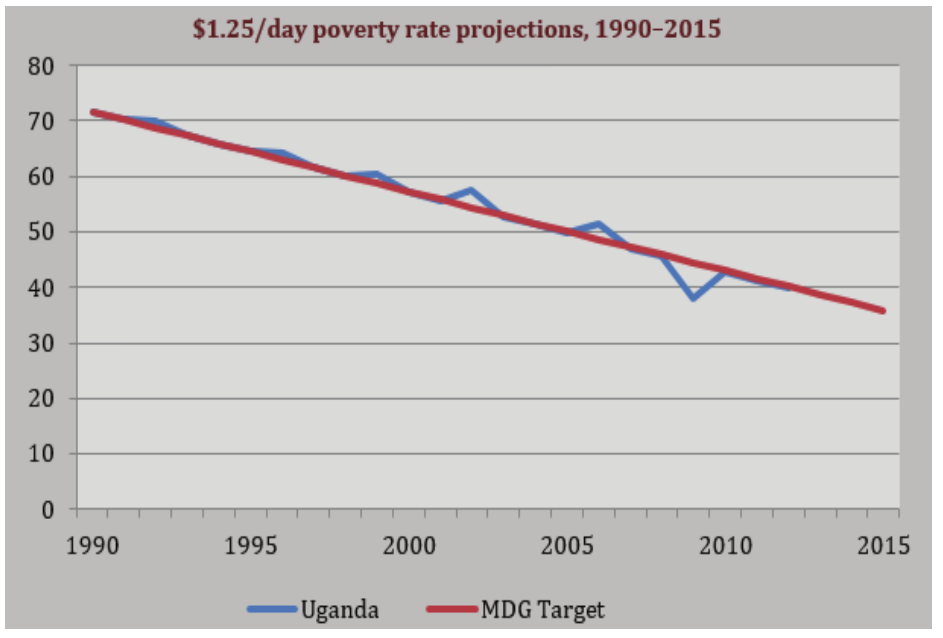
Source: ReSAKSS, based on World Bank